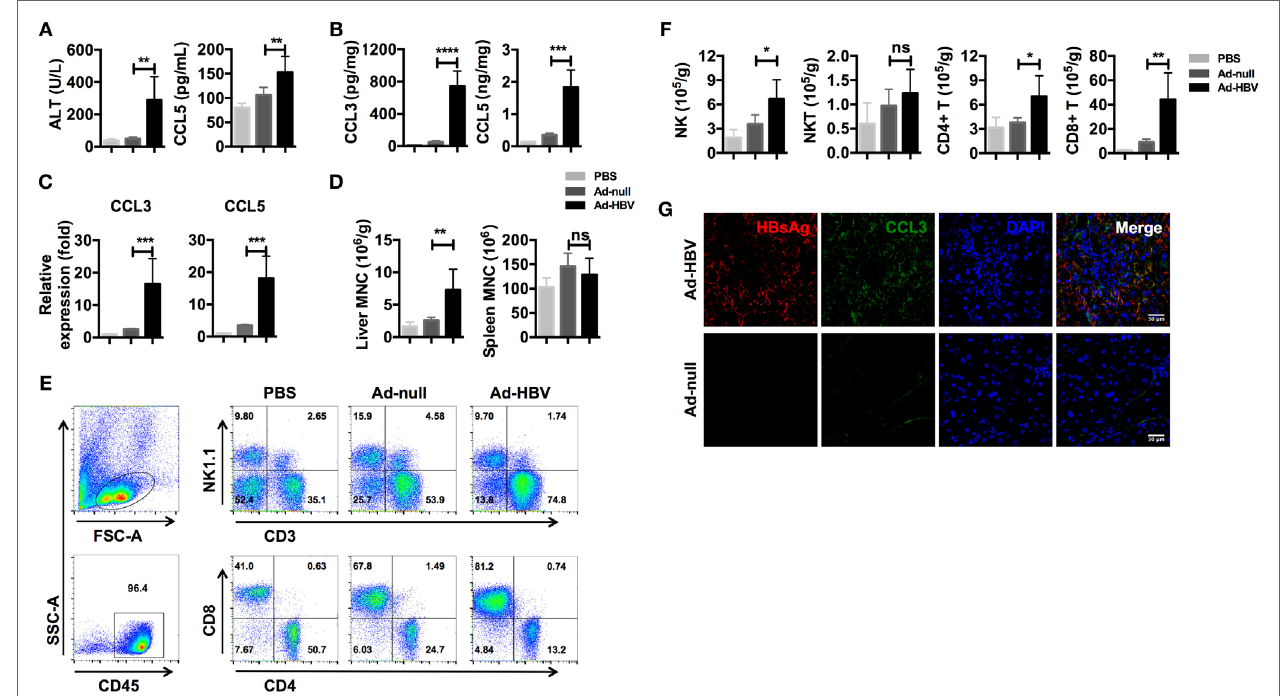
FigUre 2 | ad-hBV infection induces the secretion of inflammation-associated chemokines in the liver . (a–g) C57BL/6 mice were injected i.v. with 1 × 10 9 pfu Ad-HBV/200 μ l PBS (Ad-HBV group) or 1 × 10 9 pfu Ad-null/200 μ l PBS (Ad-null group). About 200 μ l of PBS was injected as a normal control (PBS group). Six mice were included in each group. Six days post-injection, the mice were sacrificed for the analysis. (a) Serum ALT and CCL5 levels in the mice. (B) CCL3 and CCL5 levels in the mouse livers. (c) CCL3 and CCL5 mRNA expression levels in the mice. (D–F) Mouse livers were harvested for weighing and mononuclear cell isolation. The numbers of total mononuclear cells in the livers and spleens were counted (D) . Then, the lymphocyte subtypes were analyzed by flow cytometry (e) . The number of cells of each lymphocyte subtype was calculated (F) . Frozen sections of mouse livers were stained for HBsAg and CCL3 using immunofluorescence. Scale bars: 30 μ m (g)